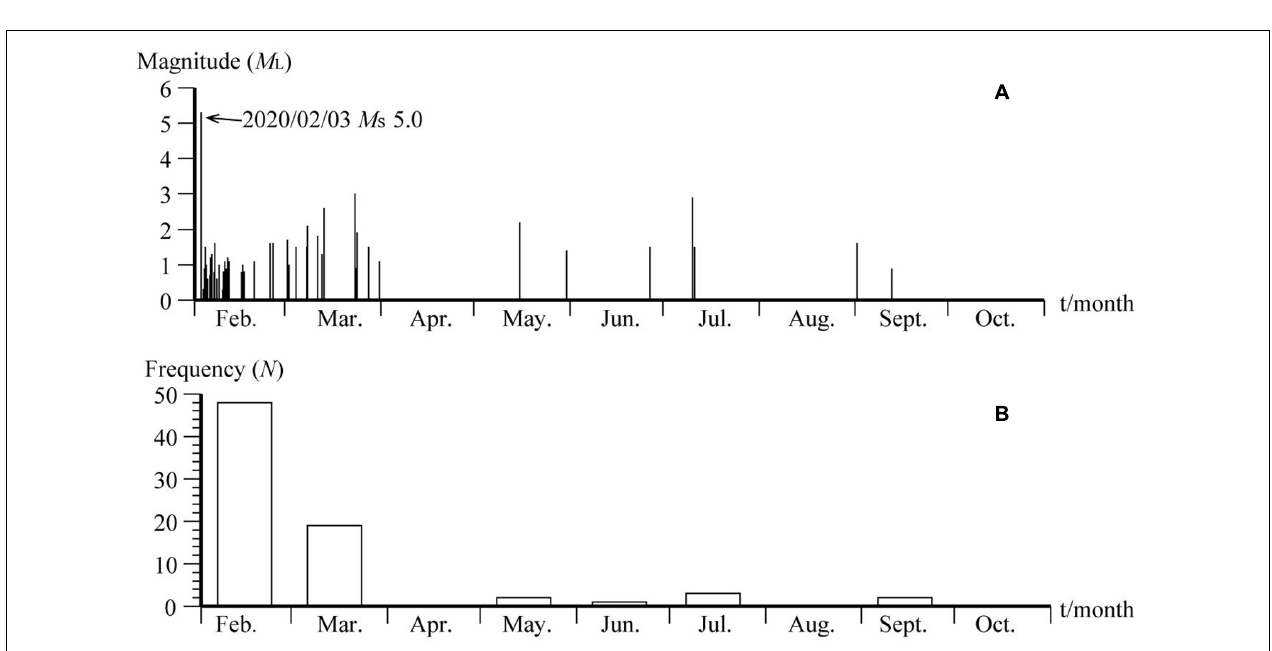
FIGURE 4 | M – t (A) and N – t (B) plots of the M L ≥ 0.1 events in the M S 5.1 Qingbaijiang earthquake sequence during the 3 February–31 October 2020 period.